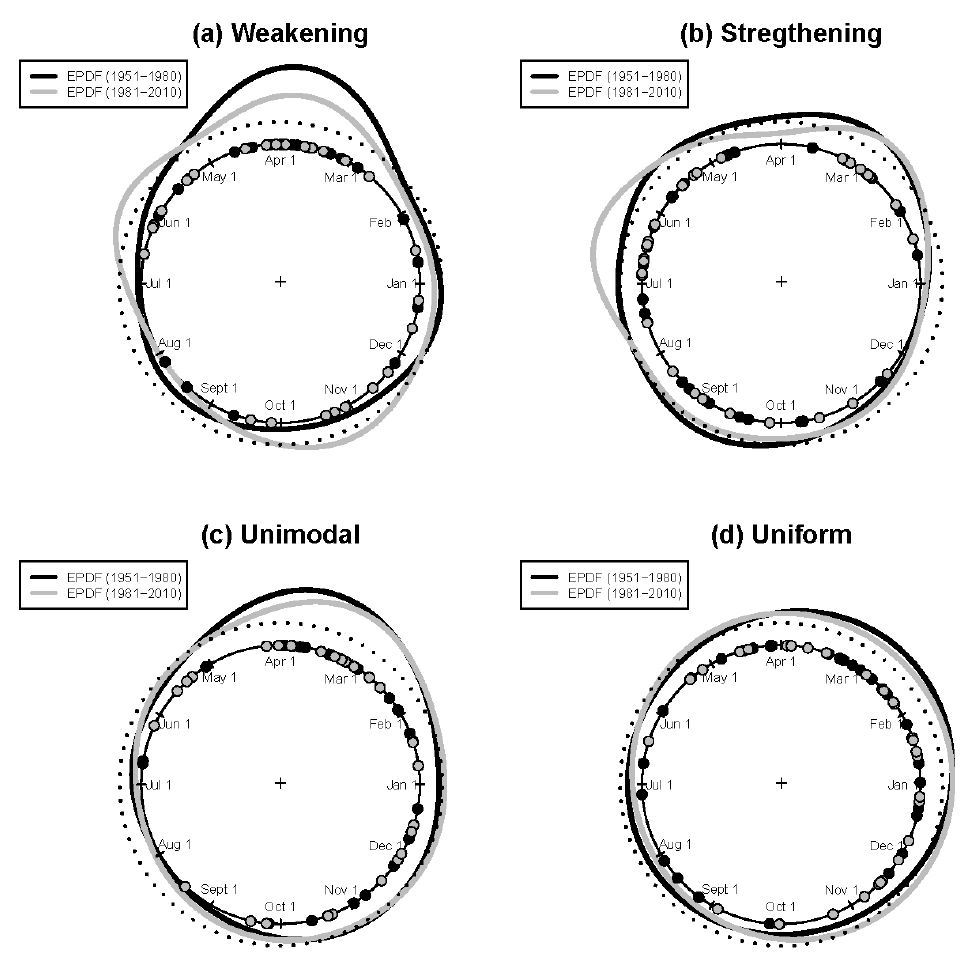
Figure 5. Four different cases of changes in seasonal modes for AMF dates identified based on circular density estimates; ( a ) weakening of seasonality for Hubbard River near West Hartland in Connecticut, ( b ) strengthening of seasonality for Rapid Creek near Iowa City in Iowa; ( c ) unimodal and strong seasonality for Blockhouse Creek near the English Center in Pennsylvania; ( d ) uniform or no preferred seasonality for S F Quantico Creek near Independent Hill in Virginia. Black and grey lines represent density estimates for the periods 1951–1980 and 1981–2010 respectively, and the dotted line represents a 95% estimate of significance (uncertainty) from bootstrap resampling.